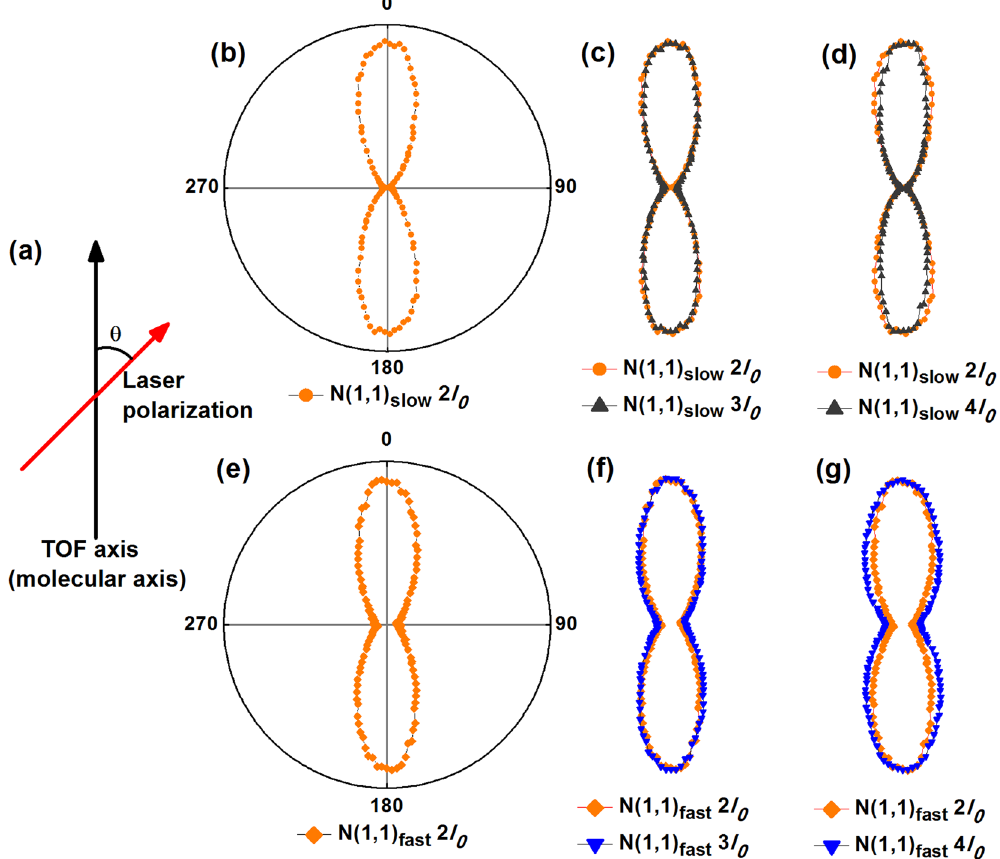
Figure 2. Polar charts of measured angular distribution of N(1,1) slow [( b – d )] and N(1,1) fast [( e – g )] at different laser intensities: 2 I 0 , 3 I 0 , and 4 I 0 , where I 0 = 10 14 W/cm 2 . The magnitude of the data points is normalized to fit the window and for easy comparison by overlapping with other distribution profile, and therefore is in arbitrary units. The profile at 2 I 0 is superimposed in each of the other profiles at 3 I 0 and 4 I 0 for each channel. The lower half of the data in each panel is mirrored from the upper half. ( a ) Illustration of the geometric configuration of the experimental setup. The TOF axis (i.e. the molecular axis) is vertical in this plane while the direction of laser polarization varies at angle θ with respect to the TOF axis in the same